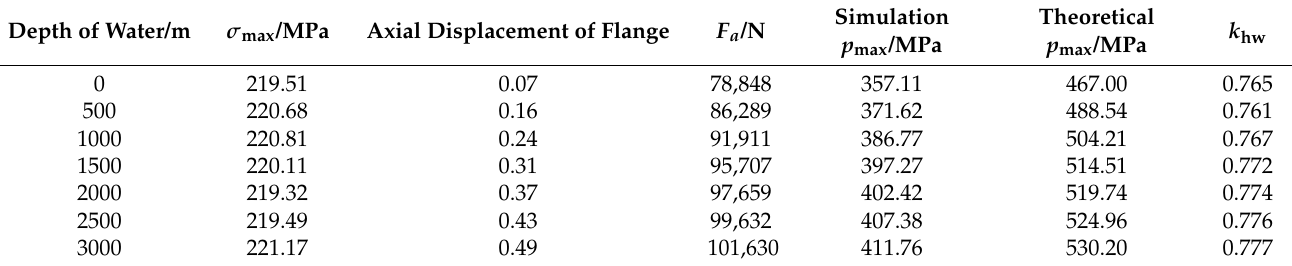
Table 5. Correction coefficient k hw under different water depths (internal pressure 41.4